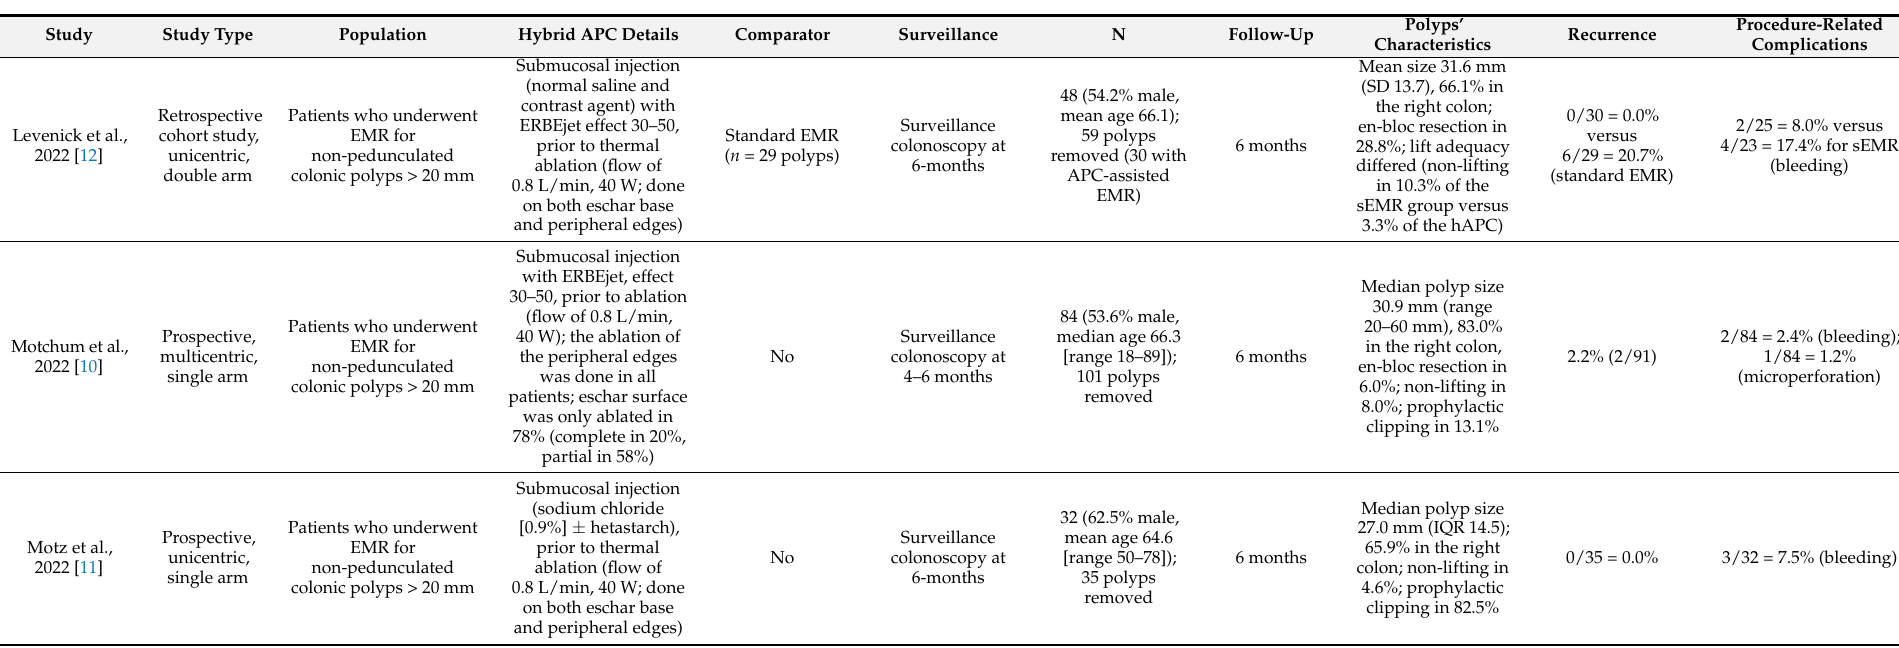
Table 2. Summary of the studies evaluating hybrid argon plasma coagulation (hAPC)-assisted endoscopic mucosal resection (EMR) of colonic lesions.